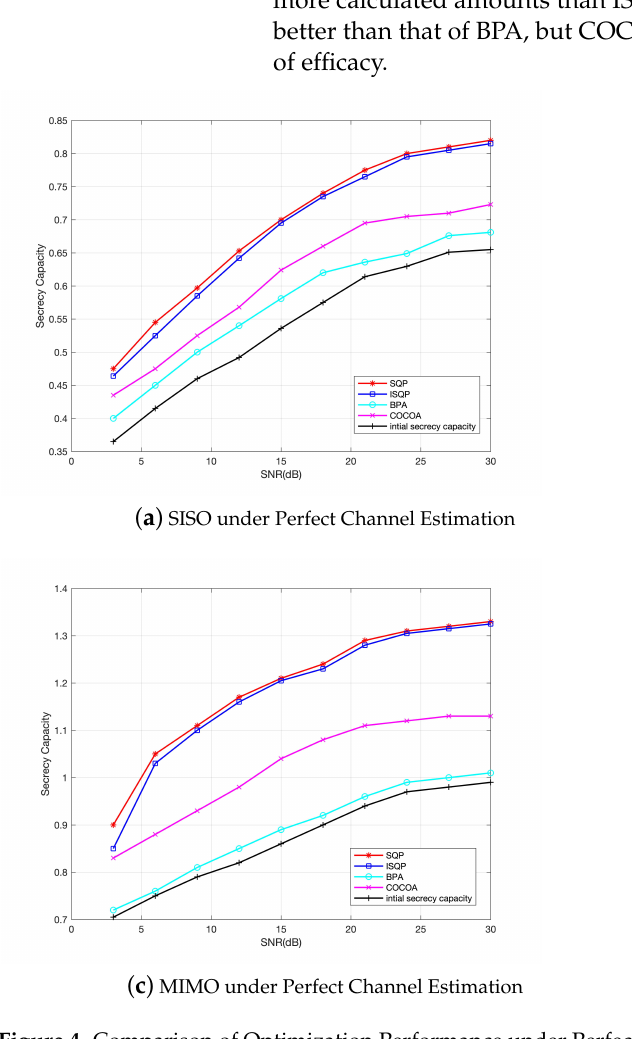
Figure 4. Comparison of Optimization Performance under Perfect and Imperfect Channel Estimation versus Different